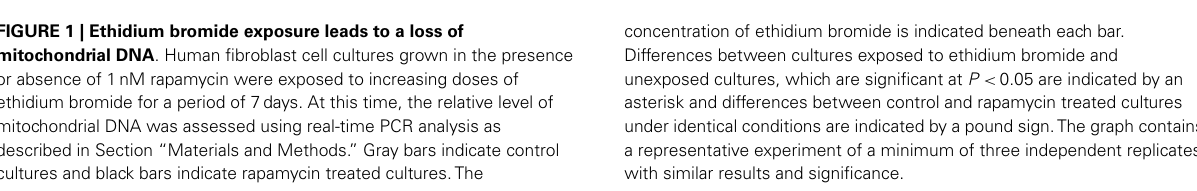
concentration of ethidium bromide is indicated beneath each bar. Differences between cultures exposed to ethidium bromide and unexposed cultures, which are significant at P < 0.05 are indicated by an asterisk and differences between control and rapamycin treated cultures under identical conditions are indicated by a pound sign.The graph contains a representative experiment of a minimum of three independent replicates with similar results and